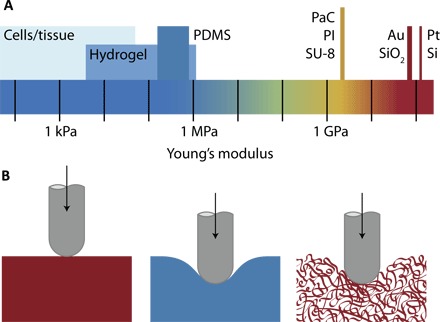
Mechanical mismatch between common probe materials and soft neural tissue.(A) Young’s modulus of tissue and common materials discussed. (B) Schematic illustrating the mechanical compliance of stiff inorganic materials (Si, metals, oxides; left), compared to elastomers like poly(dimethylsiloxane) (PDMS; middle); by minimizing the critical dimensions, high modulus and nominally rigid materials can be made compliant (right).